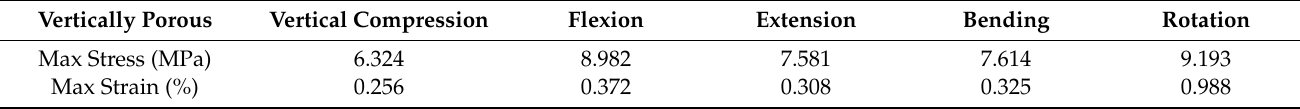
Table 14. The max stress and strain of the vertically porous gradient